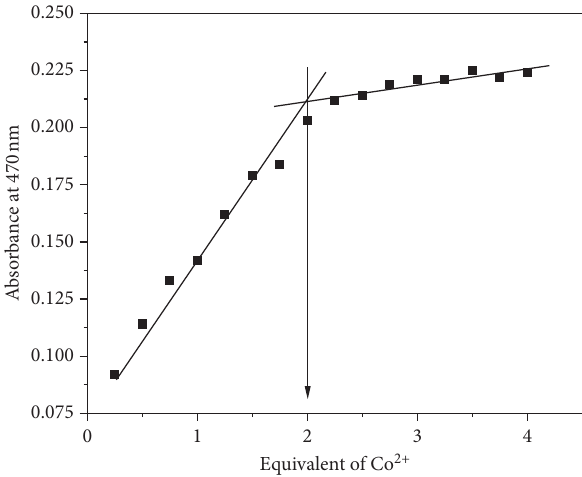
Figure 7: The visible absorption titration of 0.2mM.